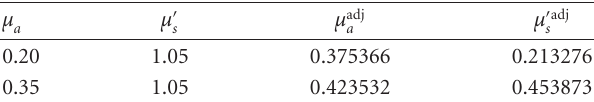
Table 2: Optical parameters optimization results. The unit was